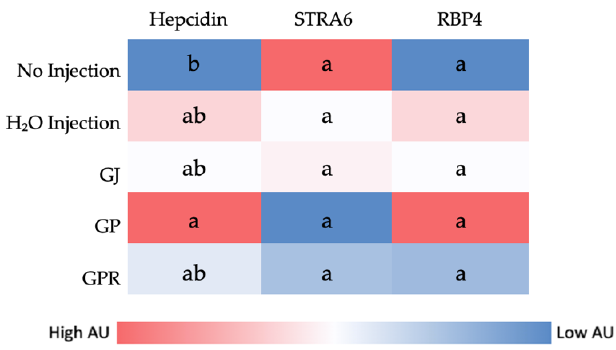
Figure 3. Heatmap showing the effect of intra-amniotic administration of grape juice (GJ), pomace (GP), and puree (GPR) on liver gene expression. Values are in arbitrary units (AU). Genes not indicated by the same letter (a,b,c) are significantly different ( p < 0.05). Key; STRA6: Signaling receptor and transporter of retinol; RBP: Retinol-binding protein.